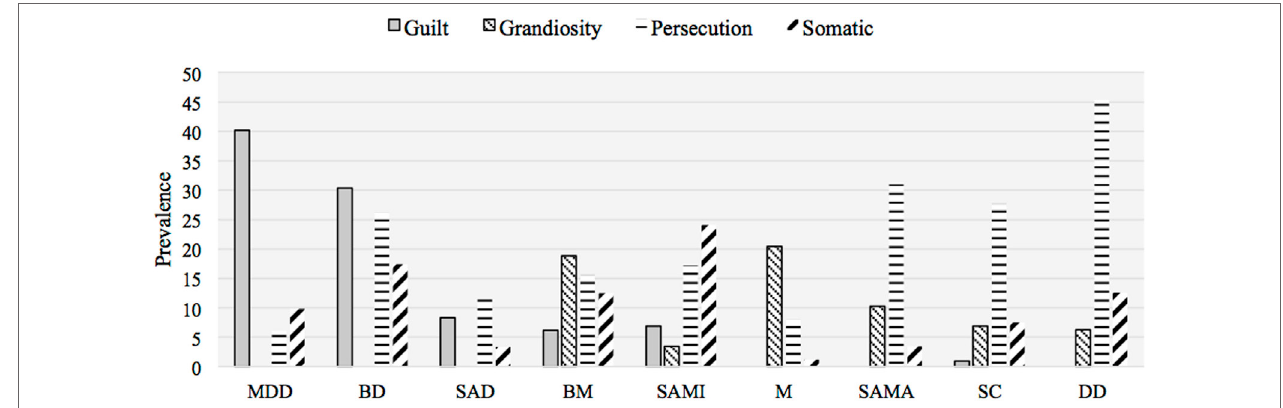
FigUre 1 | Prevalence of delusional themes by diagnostic group ( N = 830). MDD, major depressive disorder; BD; bipolar disorder, depressive episode; SAD, schizoaffective disorder, depressive type; BM, bipolar disorder, mixed episode; SAMI, schizoaffective disorder, mixed type; M, mania; SAMA, schizoaffective disorder, manic type; SC, schizophrenia; DD, delusional